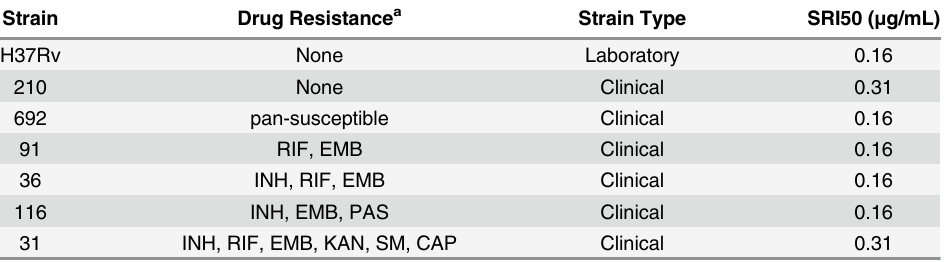
Table 4. Activity of SRI50 against wild type and clinical MDR-TB